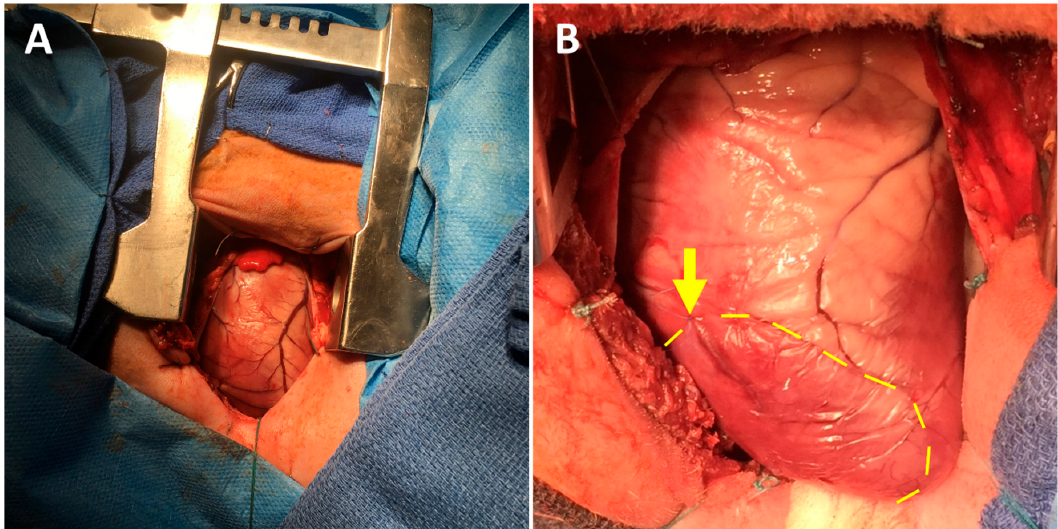
Figure 1. Ovine myocardial infarction model using a mini left thoracotomy approach. ( A ) The left ventricle is exposed through a fifth interspace mini left thoracotomy incision. ( B ) Diagonal branches of the left anterior descending coronary artery are ligated using 5-0 or 6-0 polypropylene sutures (arrow), producing a consistently-sized pale and hypokinetic infarct zone (bounded by dotted line). The infarct borderzone lies immediately beyond the dotted yellow line.